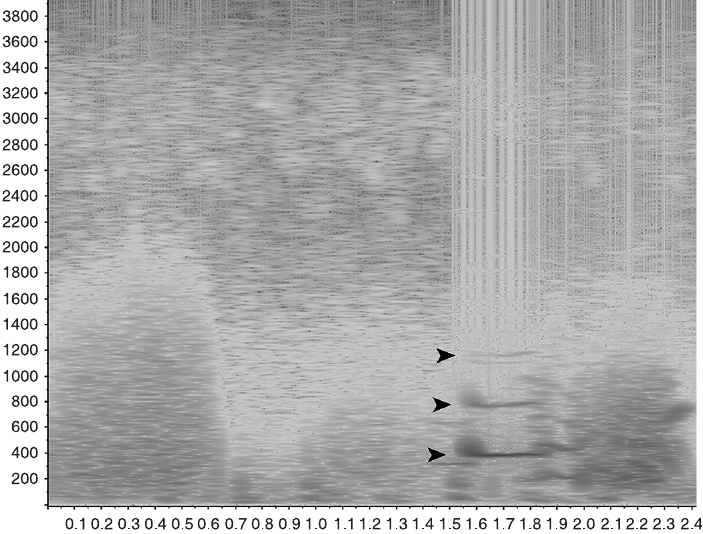
Figure 4. Spectrogram of a respiratory cycle containing fine crackles. The vertical lines